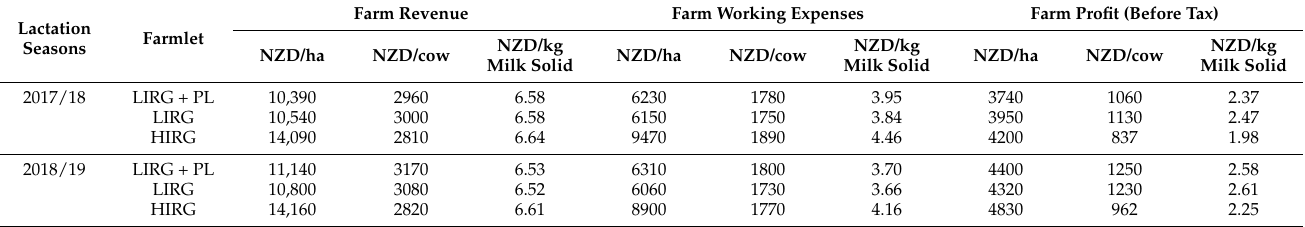
Table 5. Farmax model economic output (in New Zealand dollar) for lower input ryegrass and plantain-based (LIRG + PL; perennial ryegrass, Italian ryegrass, white clover, and plantain diverse mix, and plantain–white clover mix sward, 3.5 cow/ha and herbage received 150 kg nitrogen/ha), lower input ryegrass-based (LIRG; perennial ryegrass–white clover mix sward, 3.5 cow/ha and herbage received 150 kg nitrogen/ha) and higher input ryegrass-based (HIRG; perennial ryegrass–white clover mix sward, 5 cow/ha and herbage received 300 kg nitrogen/ha) irrigated diary systems. The model financial outputs are based on actual production input data collected from each farm system over two lactation years, 2017/18 and 2018/19, and at milk price of NZD 6.5 per kg of milk solids (sum fat + protein).